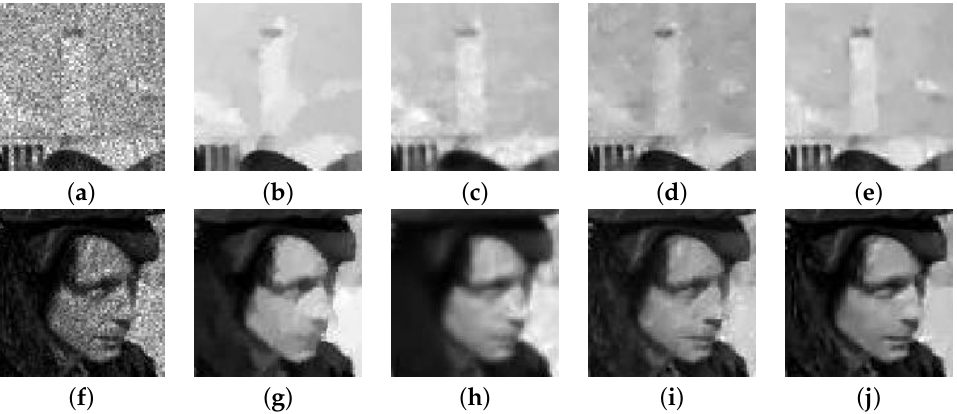
Figure 4. Zoomed-in region of Figure 3: ( a ) Degraded. ( b ) CONVEX. ( c ) OGSTVD. ( d ) M-TGV.